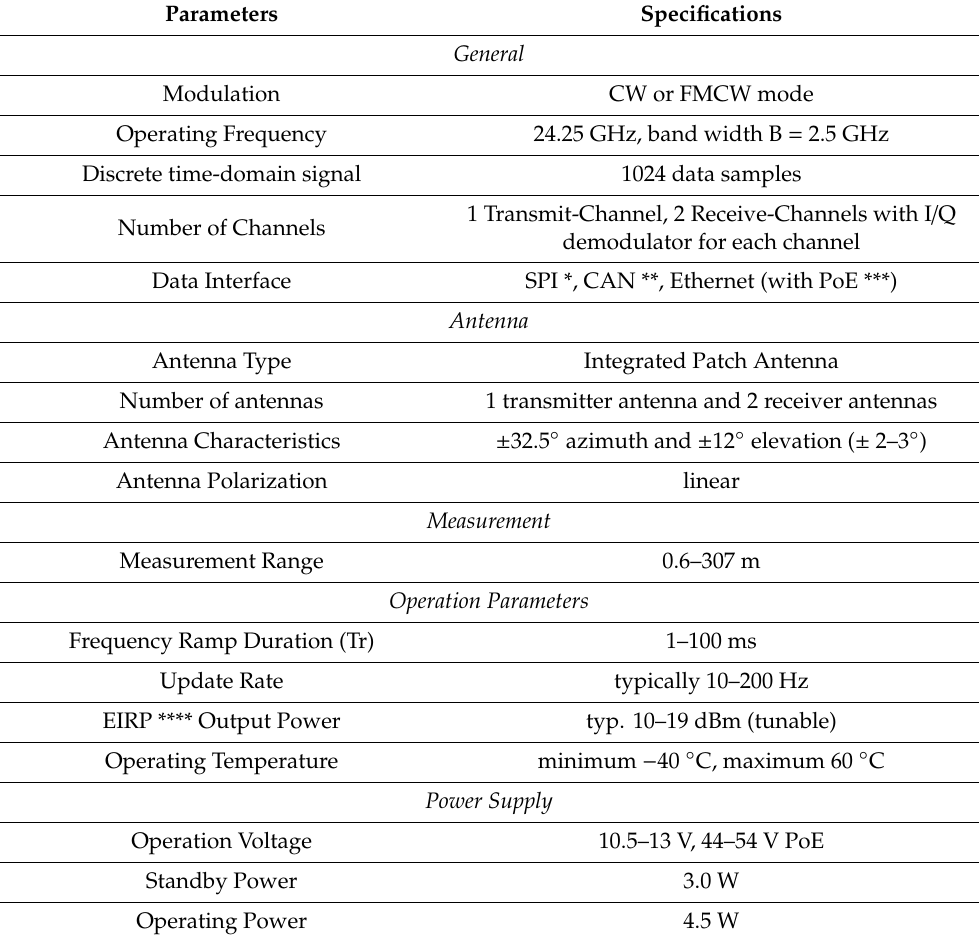
Table 1. Main specifications of IMST’s sentire TM Radar Module. The radar can be operated in continuous-wave (CW) radar mode (Doppler mode) or in frequency-modulated continuous-wave (FMCW) radar mode (see IMST [51] user guide for details).